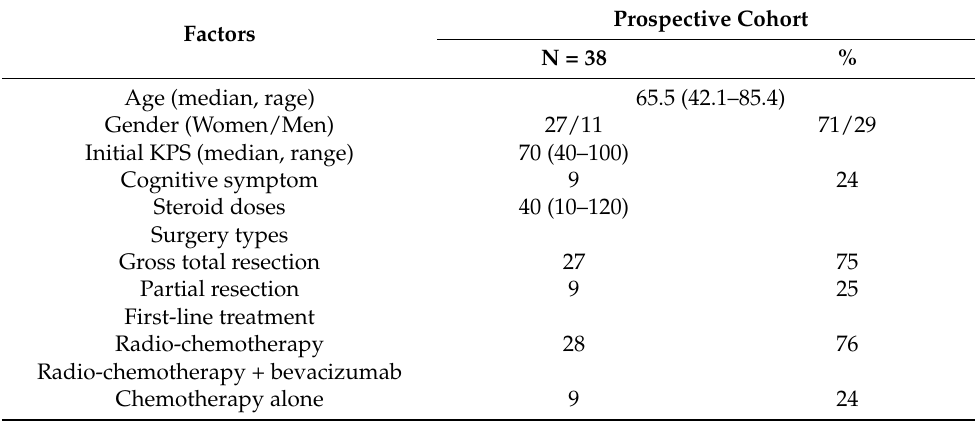
Table 1. Patient characteristics.